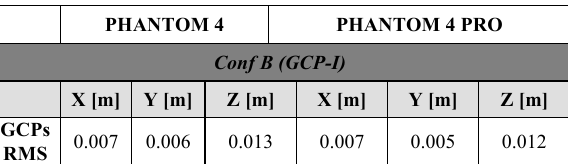
Table 1 Achieved RMS in Pix4D according flight Configuration A (all the flights) with a different number of GCPs and CPs (see section 4.1: GCP-I,II,III)